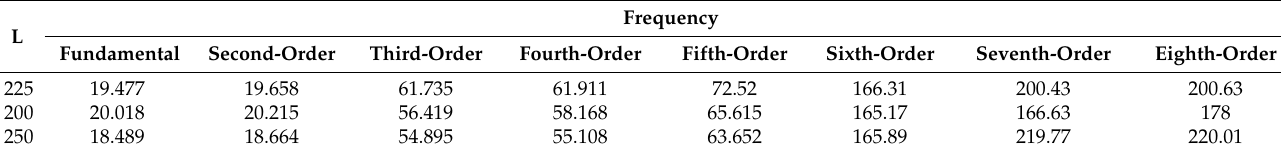
Table 5. L value brings the frequency of Weapon.